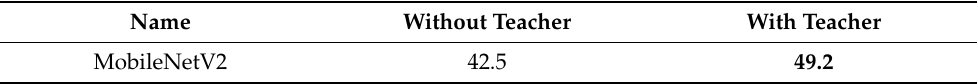
Table 2. In this table, we report the test accuracy obtained by a MobileNetV2 used as a student with an NTS-Net as a teacher over CUB200 dataset. Name Without Teacher With Teacher MobileNetV2 42.5 49.2